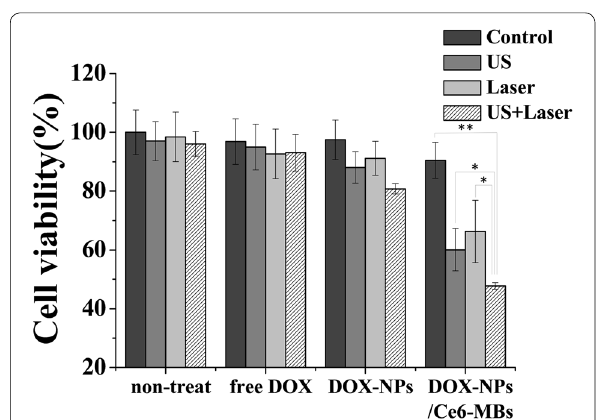
Fig. 7 Cell viability assay. Cytotoxicity of DOX-NPs/Ce6-MBs complex and its incomplete comparison groups with and without US-, Laser-treated combination therapy. 671 nm laser was irradiated with 1.0 J/cm 2 , 50 mW per well. US was applied with a power of 0.2 W/ cm 2 and duty cycle of 50% for 5 s per well. Statistical analysis was performed using Student’s t-test (* P < 0.05, ** P <